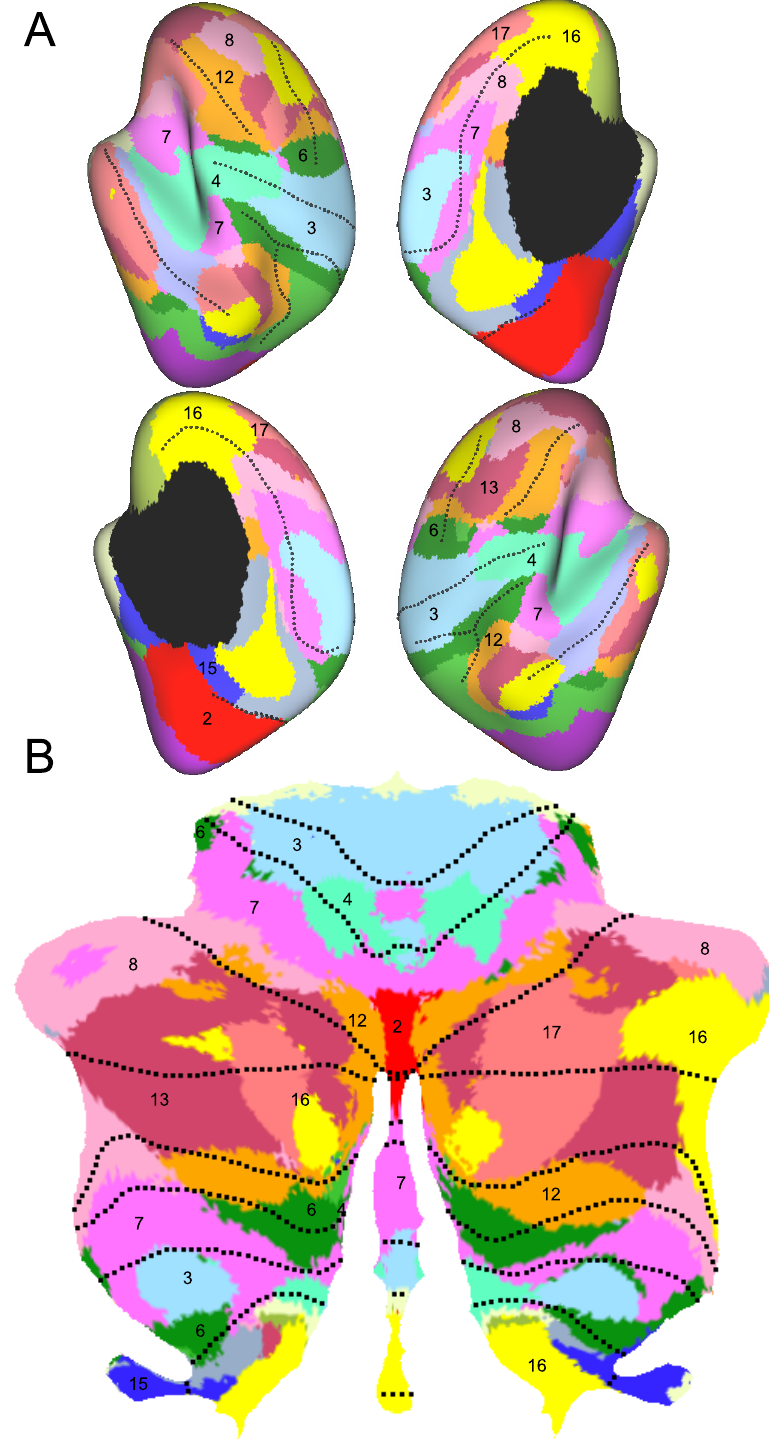
Fig 6. Atlas of cerebellar-cortical connectivity. ( A ) Cortical networks of resting-state connectivity [23]. 17 networks are shown on an inflated cortical surface of the left and right hemisphere — with both the lateral and medial surface shown. ( B ) Map showing the cortical resting-state network that correlated best with the activity in the corresponding cerebellar area [18]. Maps are based on N = 1000 subjects.